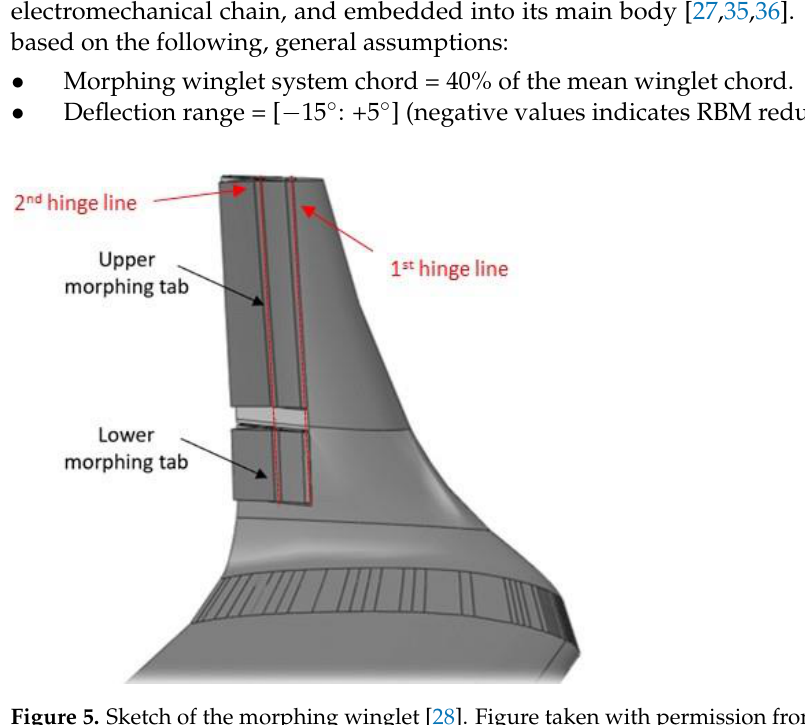
Figure 4. Morphing flap, full-scale functionality test ( left ), and static test ( right ).